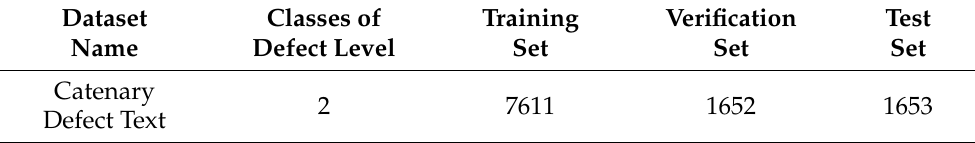
Table 1. The details of the catenary defect text classification